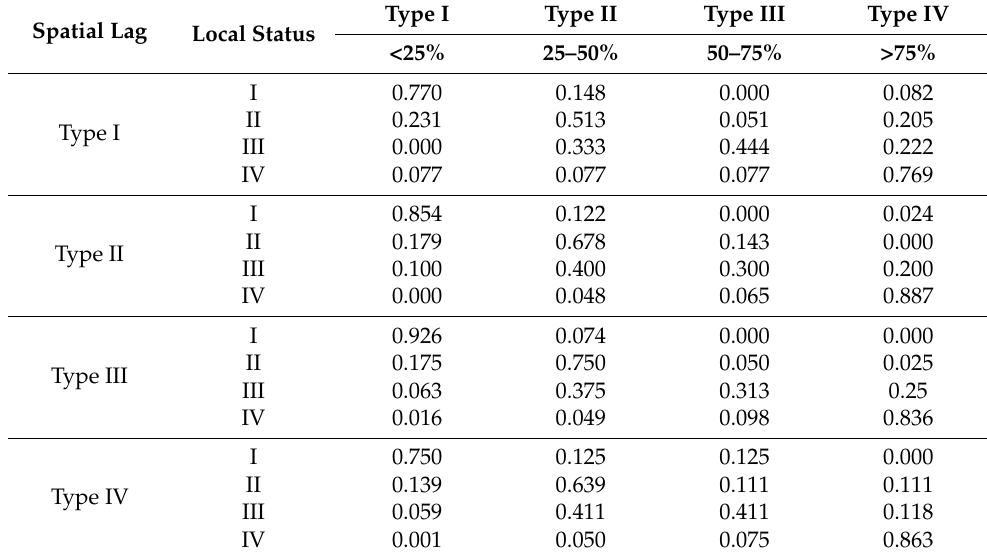
Table 4. Markov chain probability transition matrix of the CLUE in the study area from 2008 to